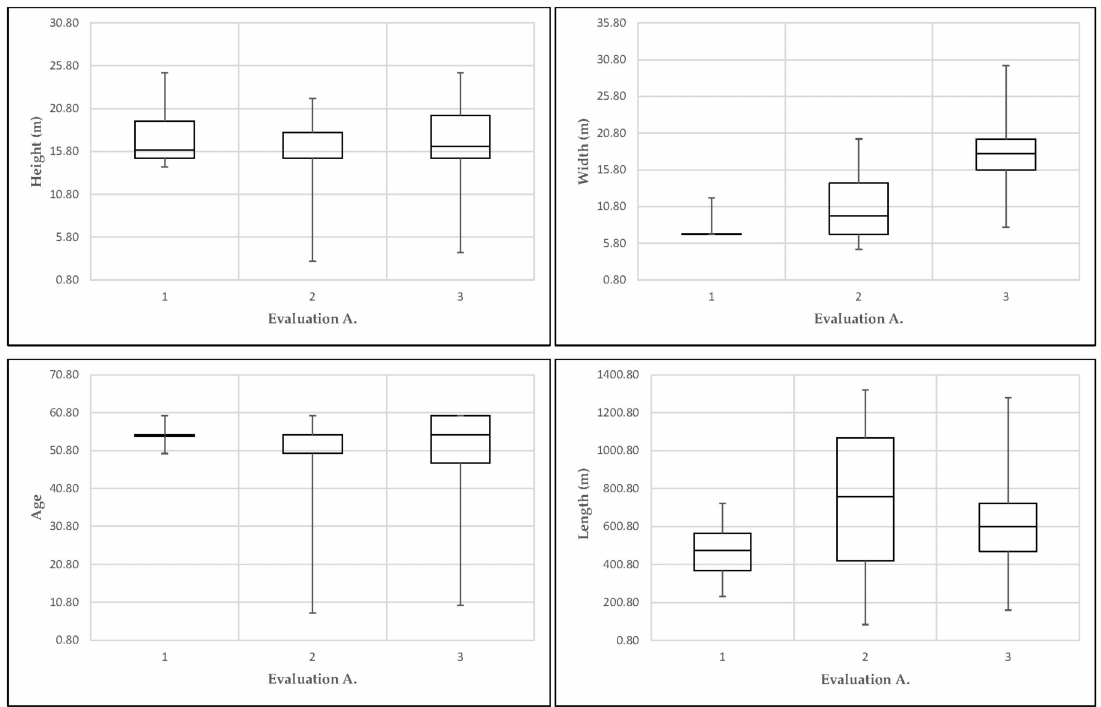
Figure 4. Boxplots of four selected spatial parameters of windbreaks.